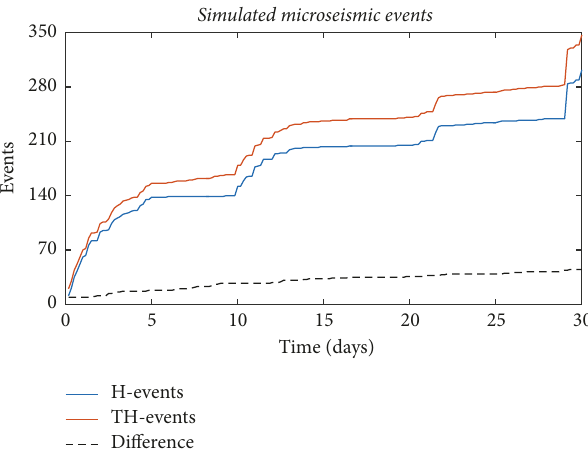
Figure 17: Temporal evolution of the simulated seismic events dur- ing the injection period. An event is counted if the corresponding fracture segment is eligible for slip. The two colors indicate the mechanism of failure. Blue: fracture segments failing due to fluid pressure alone (H). Red: failure due to the combined effects of fluid pressure and thermal stress